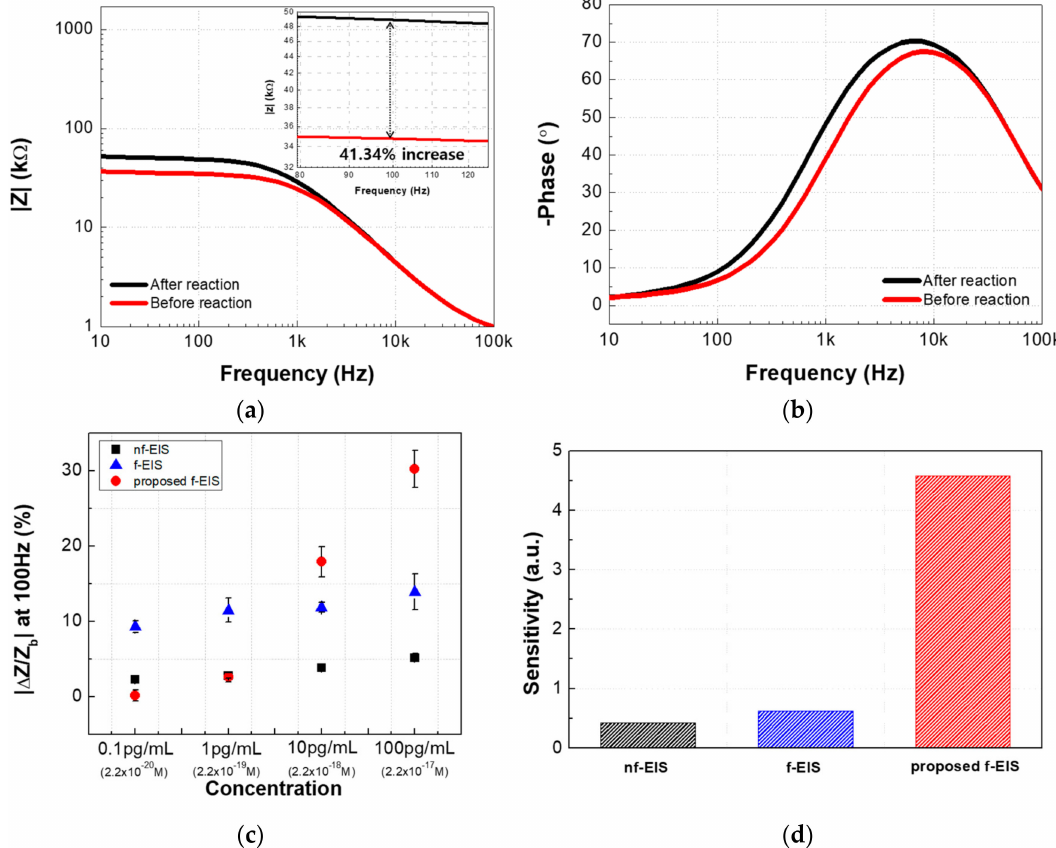
Figure 7. ( a , b ) Measured impedance spectrum (10 Hz–100 kHz) of the proposed f-EIS (the fitting residual r 2 = 0.9248). ( c ) | ∆ Z / Z b | at 100Hz vs. concentration for the three methods. ( d ) Slope of Figure 7a ( | ∆ Z / Z b | ( y ) vs. concentration ( x ) [pg/mL]); nf-EIS: y = 0.4231 × ln( x ) + 3.0236, r 2 = 0.9671; f-EIS: y = 0.6164 × ln( x ) + 10.924, r 2 = 0.9446; proposed f-EIS: y = 4.5859 × ln( x ) + 7.4451, r 2 =